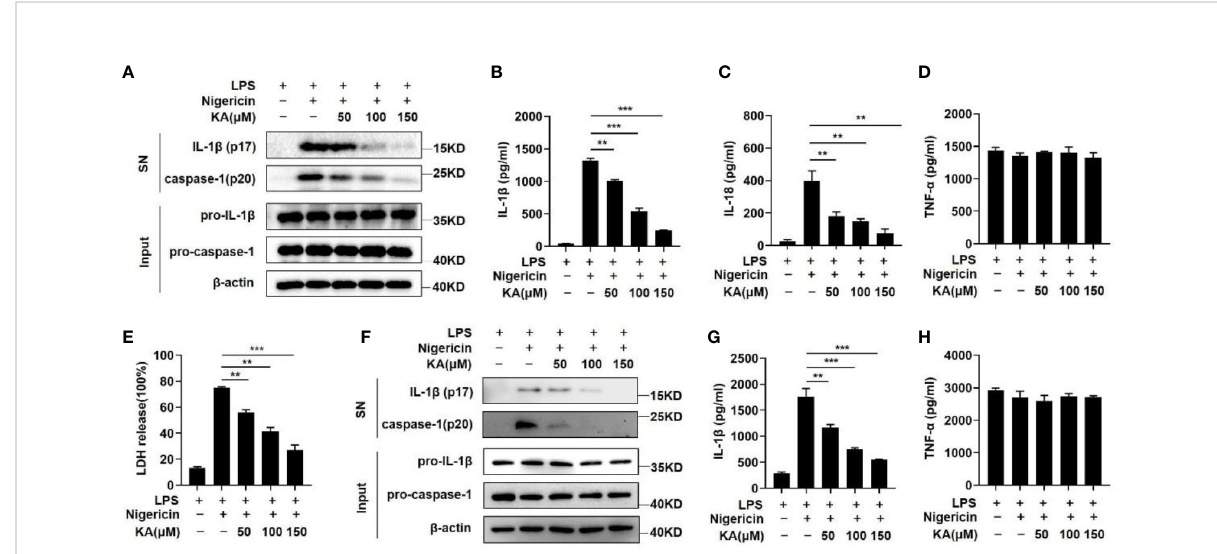
FIGURE 1 KA suppressed NLRP3 in fl ammasome-mediated caspase-1 activation and IL-1 b secretion. LPS-primed BMDMs or THP-1 cells were pretreated with KA at different concentrations for 2 hours and then stimulated with nigericin. (A) Western blot analysis of IL-1 b and cleaved caspase-1 (p20) in the supernatants (SN) of BMDMs and western blot analysis of pro-IL-1 b and pro-caspase-1 in the lysates (input) of BMDMs. (B) ELISA of IL-1 b in the SN of BMDMs. (C) ELISA of IL-18 in the SN of BMDMs. (D) ELISA of TNF- a in the SN of BMDMs. (E) Lactate dehydrogenase (LDH) levels in the SN of BMDMs after nigericin-induced pyroptosis. (F) Western blot analysis of IL-1 b and cleaved caspase-1 (p20) in the SN of THP-1 cells and of pro-IL-1 b and pro-caspase-1 in the lysates (input) of THP-1 cells. (G) ELISA of IL-1 b in the SN of THP-1 cells. (H) ELISA of TNF- a in the SN of THP-1 cells. Data are representative of three independent experiments and show as the mean ± SEM. Statistical signi fi cance was analysed by unpaired t test: **p < 0.01, ***p <